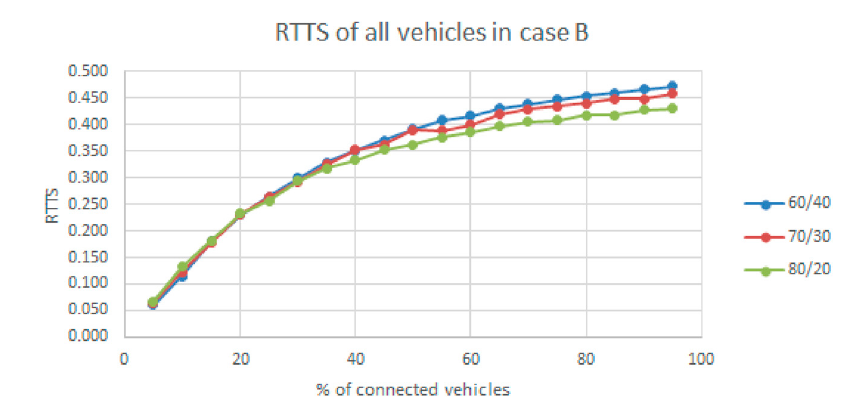
Figure 13. RTTS for all vehicles in Case B.